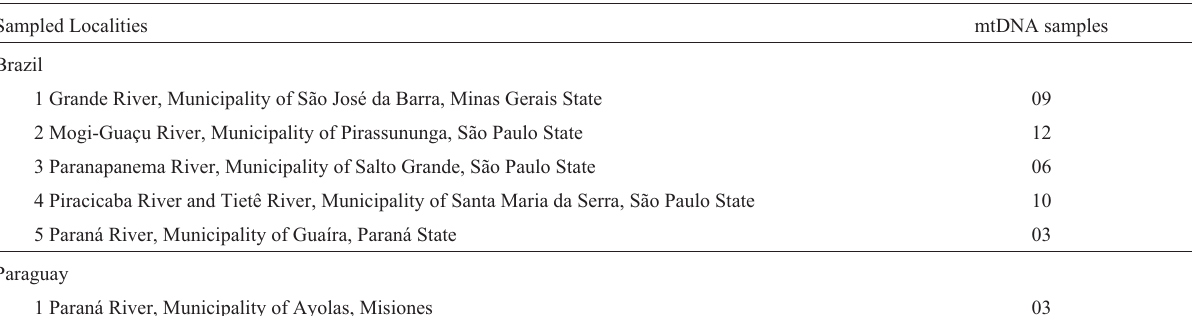
Table 1 - Leporinus elongatus collection localities and sample sizes from the Paraná River basin. Sampled Localities